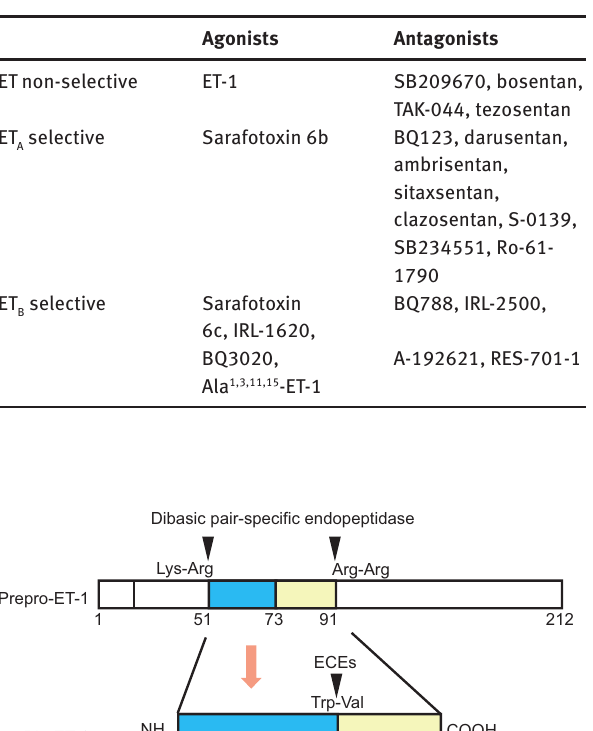
Table 1 Agonists and antagonists for ET